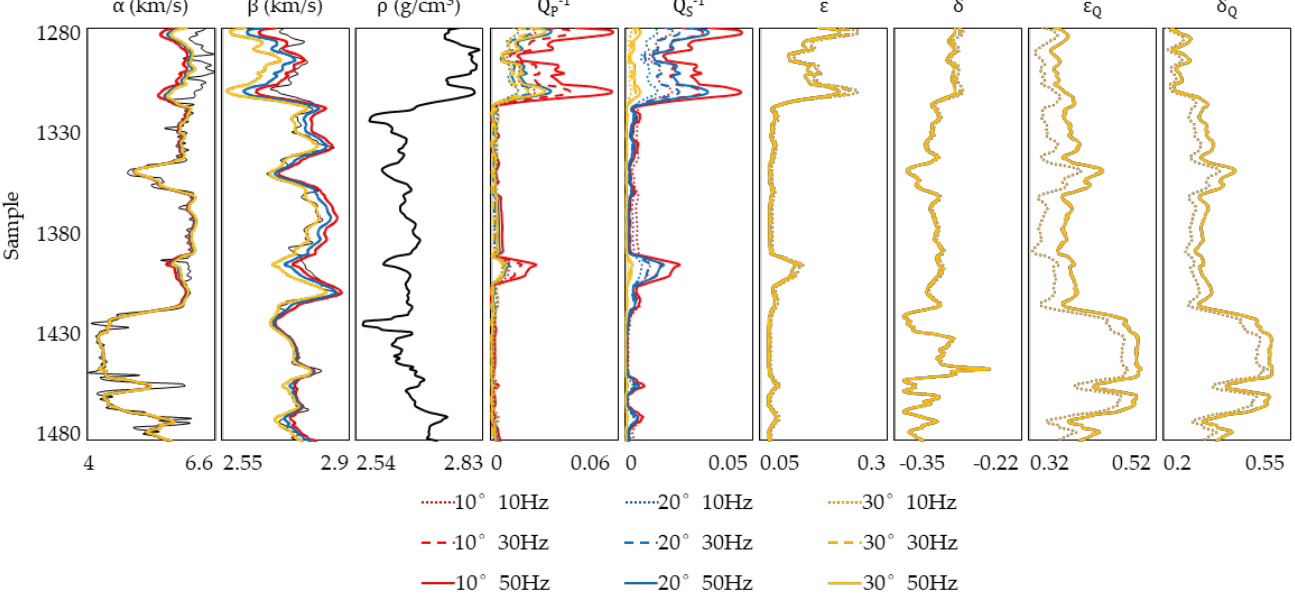
Figure 8. The synthetic seismic data for a set of frequency in small incident angles.